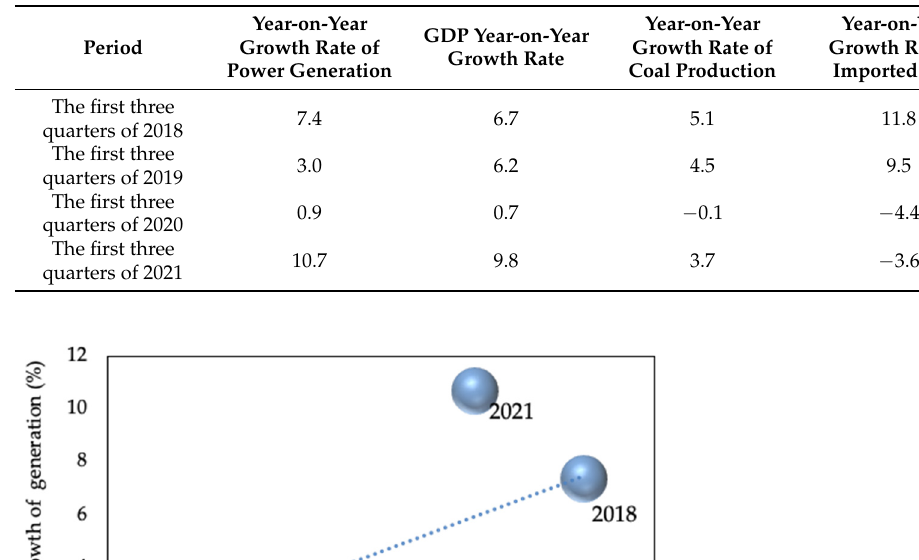
Table 2. The growth rate of power generation, GDP, coal production and imported coal amount.